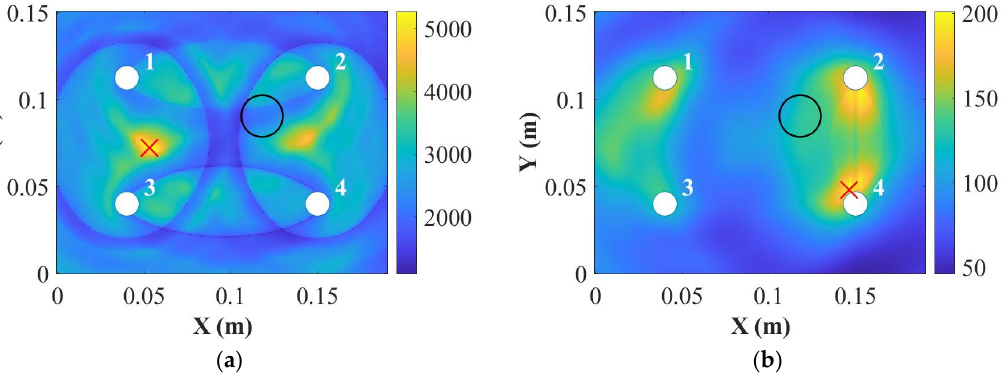
Figure 16. Damage localisations for the 9 mm thick panel at 50 kHz ( a ) and 250 kHz ( b ) (where “ ○ ” is the position for real damage and “ (cid:3400) ” is the position for predicted damage).